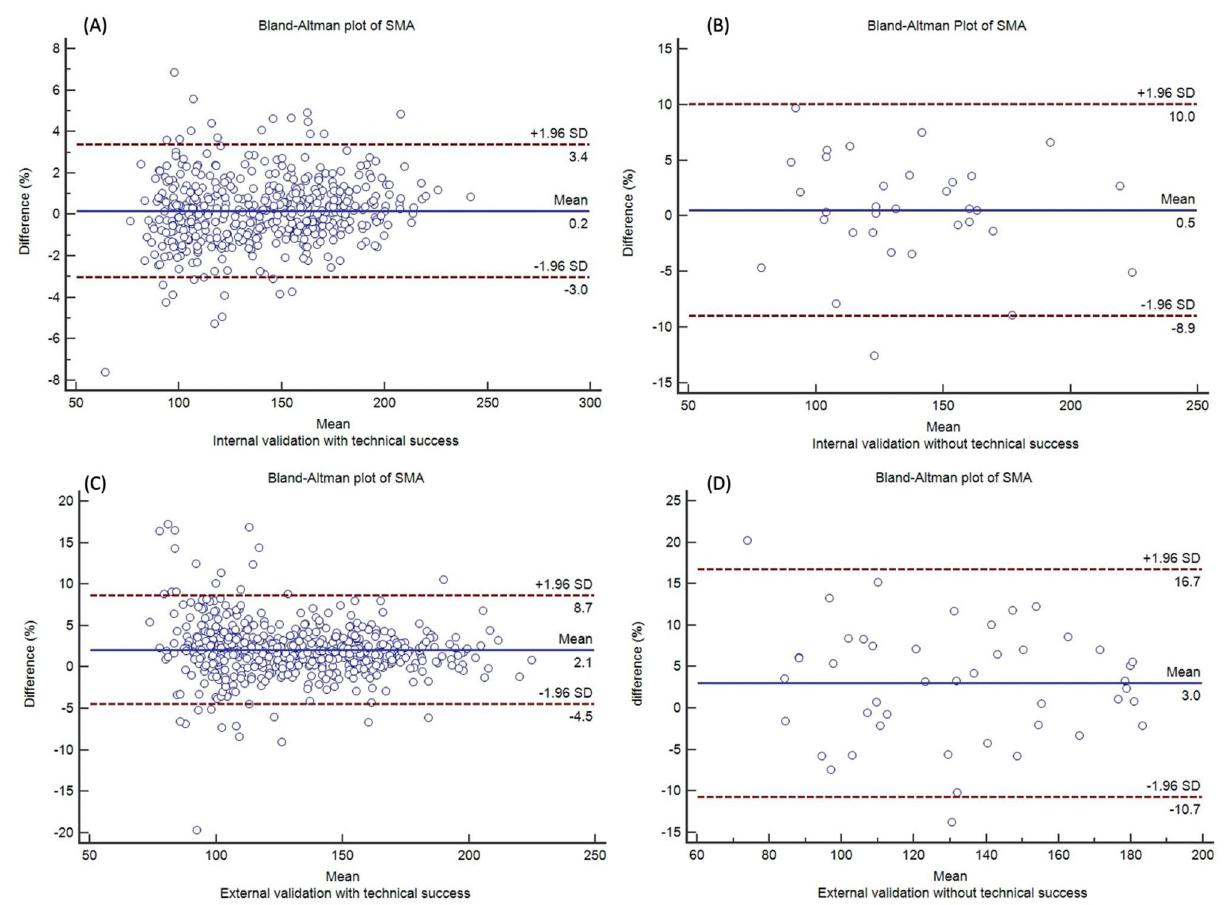
Figure 6. Bland Altman plots to evaluate agreement of SMA between the GT and DLM. (A) In subjects with technical success in the internal validation cohort, (B) in subjects with technical failure in the internal validation cohort, (C) in subjects with technical success in the external validation cohort, (D) in subjects with technical failure in the external validation cohort.